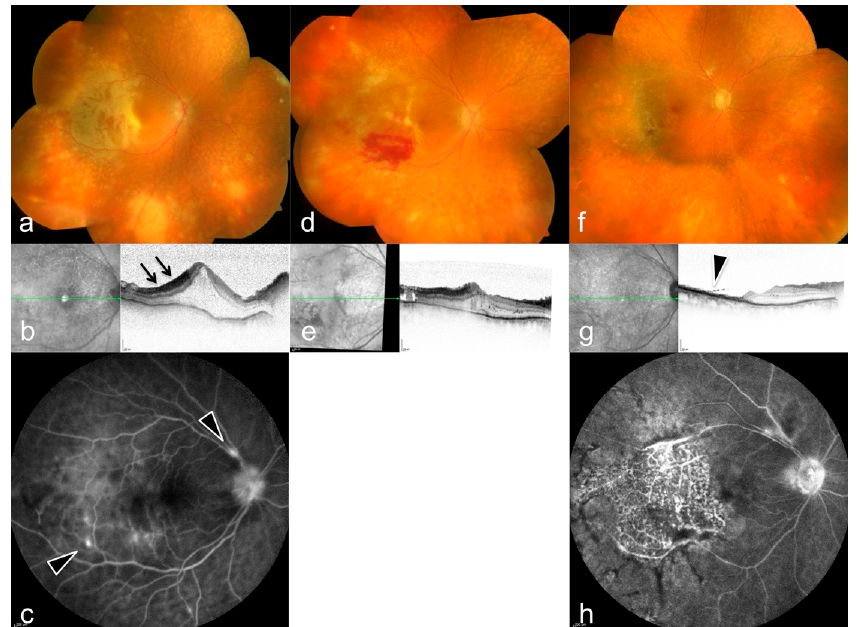
Figure 3. Bilateral onset of acute retinal necrosis (ARN). Right eye findings on first presentation: ( a ) Funduscopy with peripheral retinal infiltrations, ( b ) ischemic inner retinal layers (arrows) and edema in optical coherence tomography (OCT), ( c ) vascular leakage in fluorescein angiography (arrowheads). ( d – h ) follow-up with resolving infiltrates, development of bleedings ( d ), and retinal necrosis ( g , arrowhead). For further details see Table 1, patient 8.